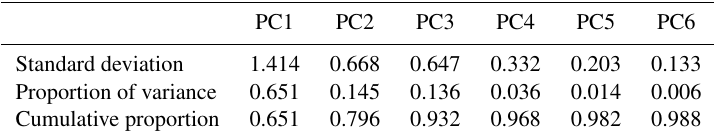
Table 2. Importance of the first six principal components in the laboratory